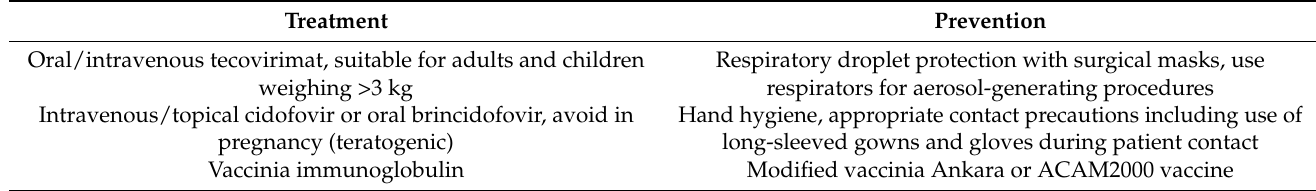
Table 5. Treatment and prevention of monkeypox virus